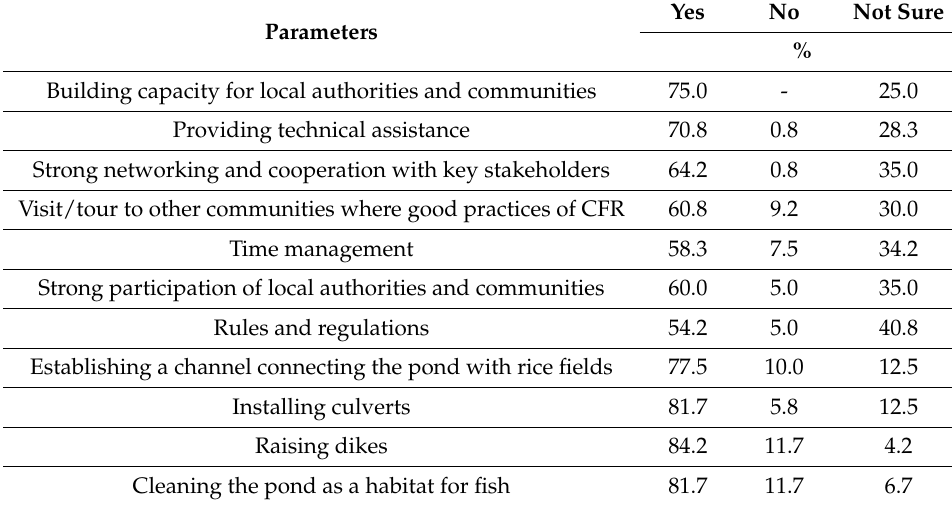
Table 6. Suggestions to improve the CFR management in the future ( N =